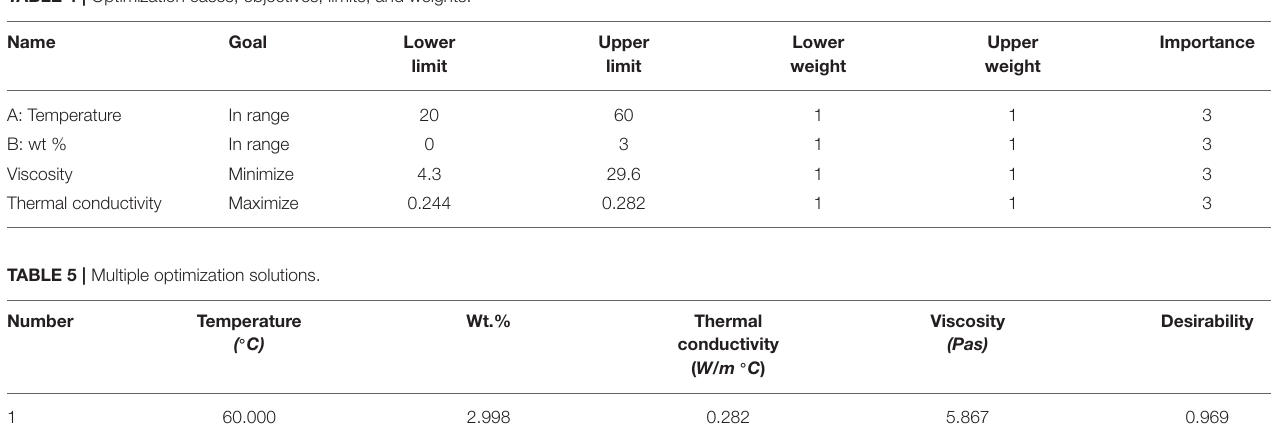
TABLE 4 | Optimization cases, objectives, limits, and weights.